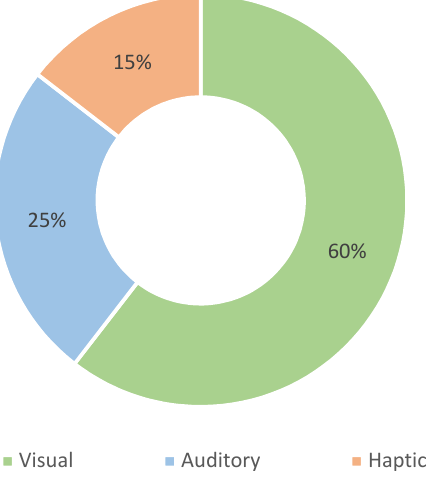
Figure 11. Utilization of feedback modalities in studies from all included papers.